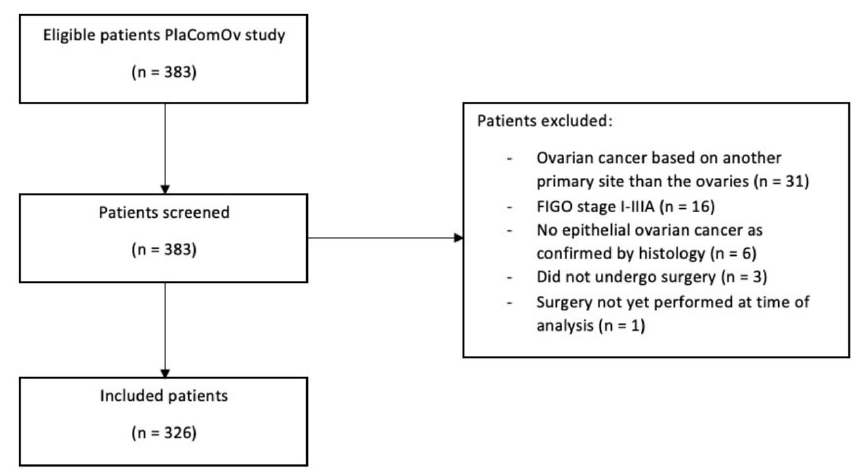
Figure 2. Flowchart of patient selection.